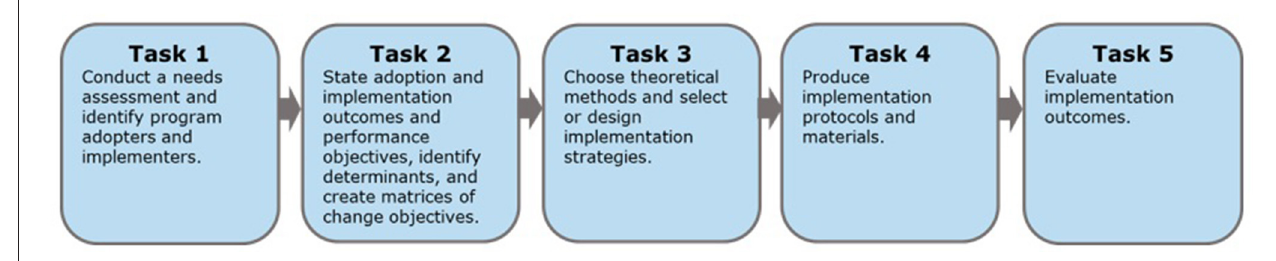
FIGURE 1 | The five steps of implementation mapping [IM; (5)].